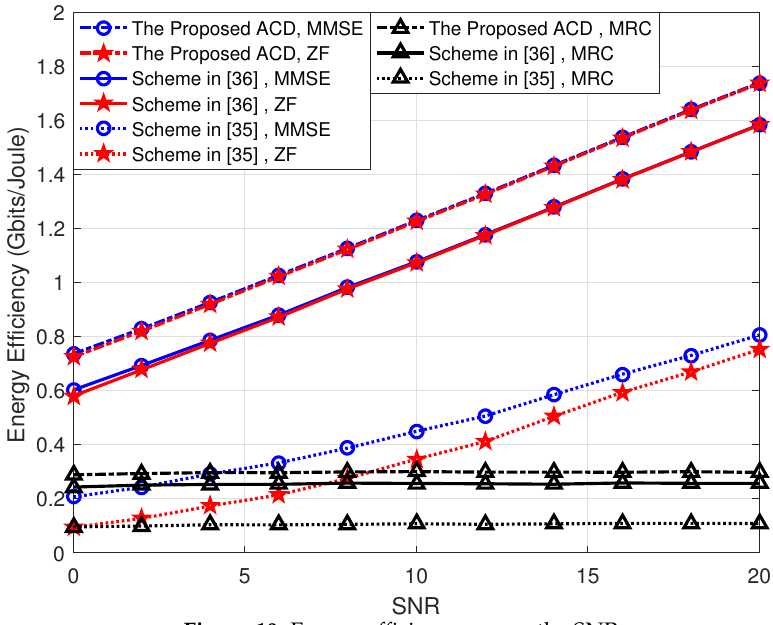
Figure 10. Energy efficiency versus the